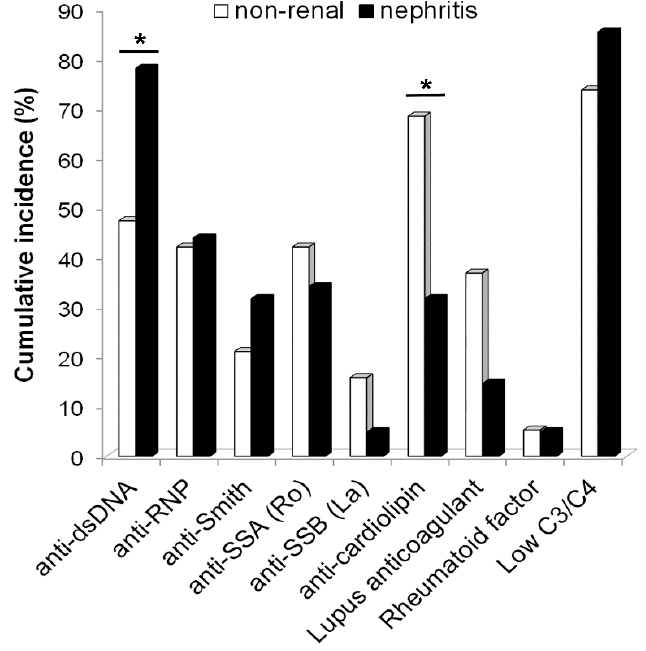
Figure 2. Proportion of males with childhood-onset SLE with and without nephritis who tested positive for specific autoantibodies or hypocomplementemia. Patients who developed kidney involvement at any time during follow-up (black, n = 59) were compared with those who never met criteria for kidney disease (white bars, n = 36). Cumulative incidence is shown, which includes testing positive at baseline or anytime during follow-up. * p -values < 0.05 for comparison between lupus nephritis and non-renal subsets.